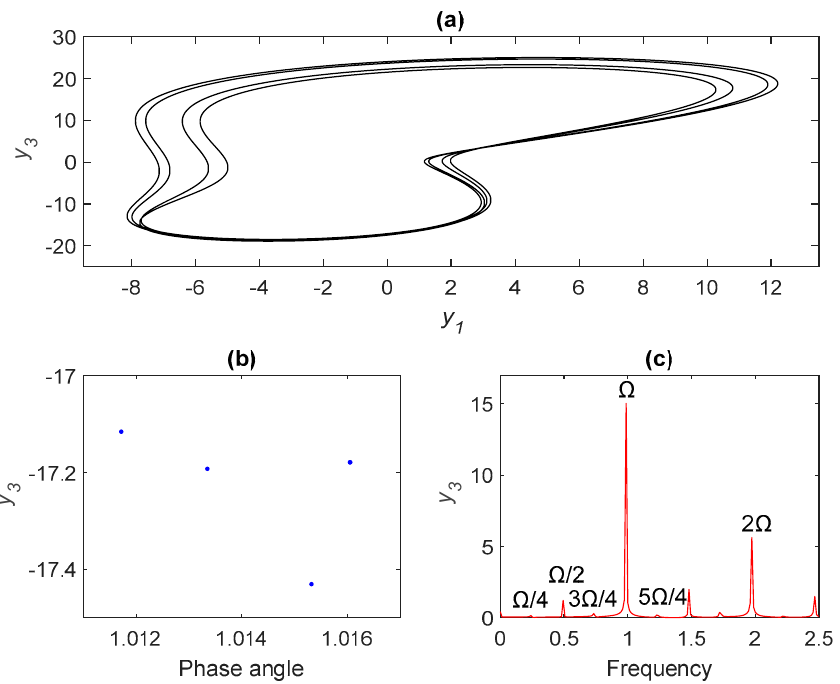
Figure 4. Period-4 orbit for σ = 4.205: ( a ) phase portraits, ( b ) Poincare maps, and ( c ) frequency spectra.